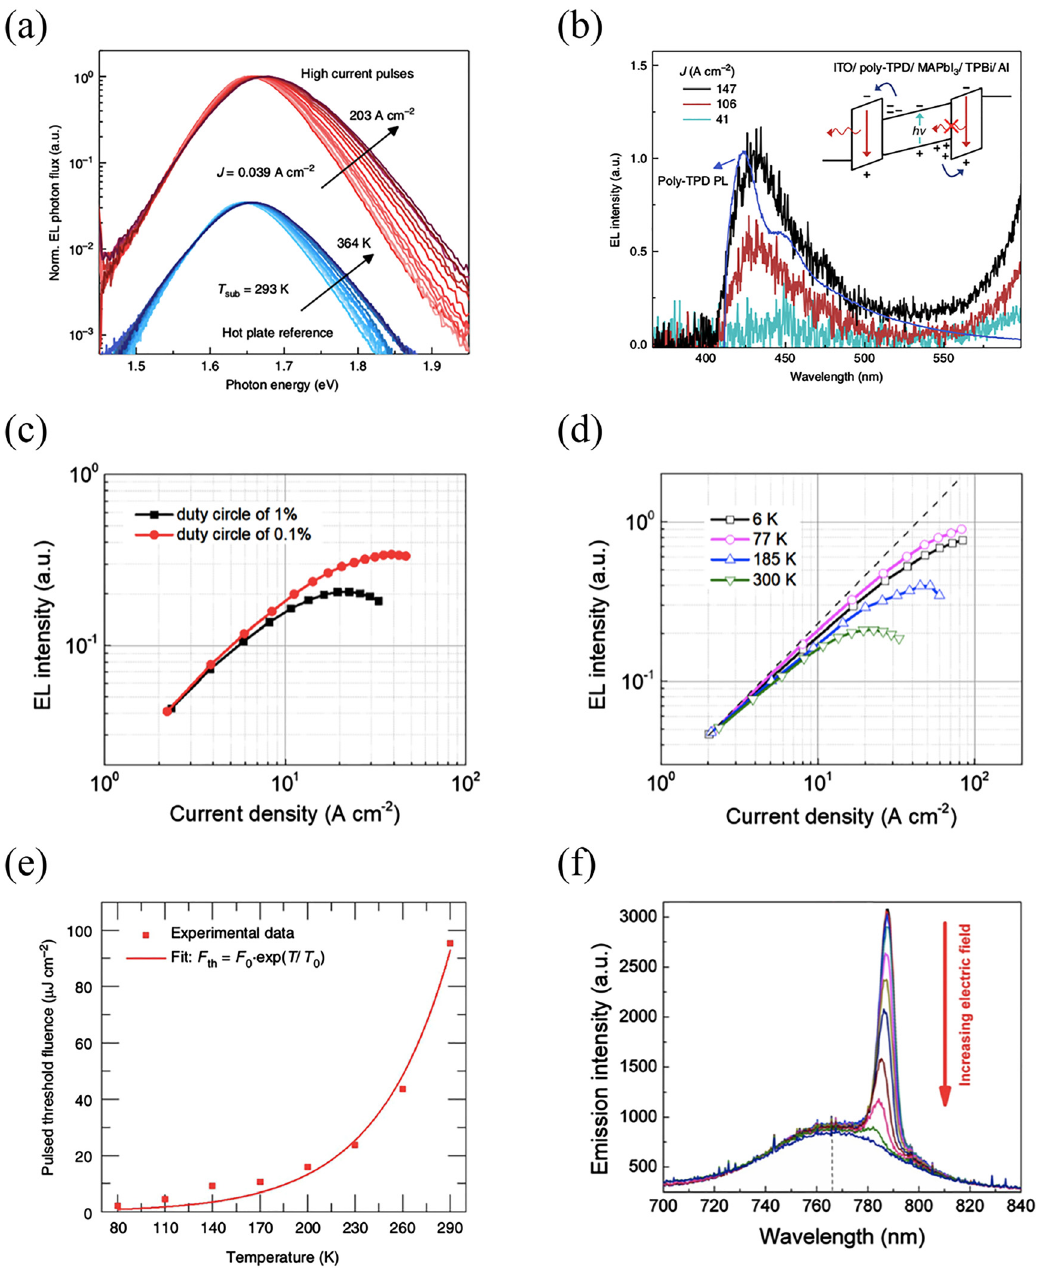
Figure 9: (a) EL spectra under different current density and temperature. (b) EL spectra under high current density, showing emission from transport layer and possible unbalanced carriers. Reproduced with permission [42]. Copyright © 2018, Springer Nature. (c) and (d) EL intensity-currentdensitycurvesunderdifferentdutycircleandenvironmenttemperature.Reproducedwithpermission[43].Copyright©2019, AIP Publishing. (e) Pulsed threshold fl uence variation with increasing the temperature. Reproduced with permission [60]. Copyright © 2019, Springer Nature. (f) Evolution of emission as the applied electric- fi eld intensity increased, showing quenching of ASE intensity. Reproduced with permission [41].Copyright © 2015, AIP